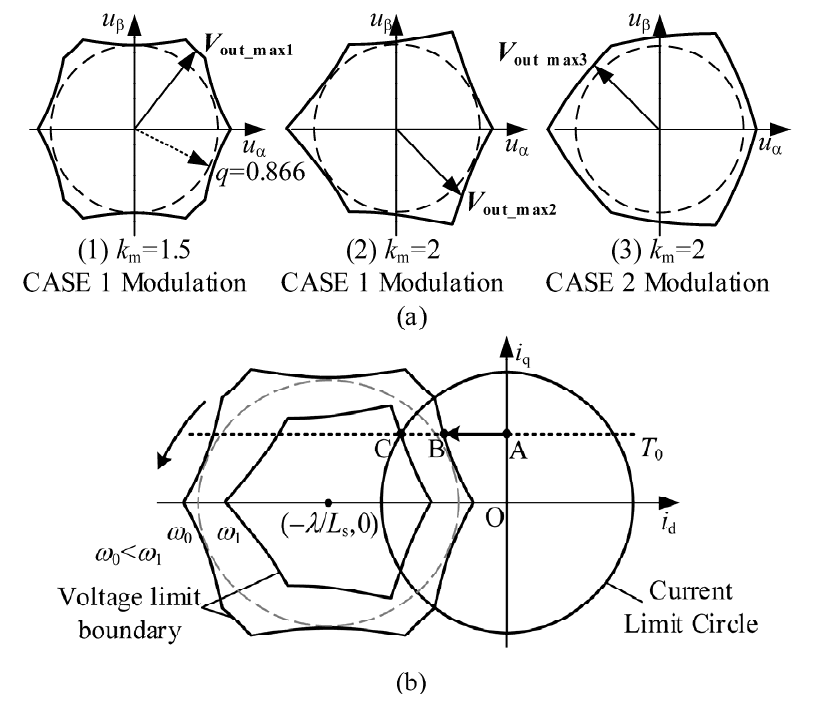
Figure 5. Trajectory of V out_max , boundary of voltage and current, and trajectory of current vector in the flux-weakening region. ( a ) Trajectory of V out_max ; ( b ) boundary of voltage and current vectors, and trajectory of current vector in the flux-weakening region. Ignoring the voltage drop on the stator resistance, the boundary of voltage and current vectors are drawn in the i d - i q coordinates according to Equations (22)–(24) and (25), as shown in Figure 5b. In the figure, the boundary of current is a limit circle centered at origin, and that of the voltage is some kind of symmetric polygon centered at ( − λ / L s , 0). The higher the speed is, the smaller the radius of the inner tangent circle of the voltage boundary is, and its shape varies in different speeds, as shown in Figure 5b.